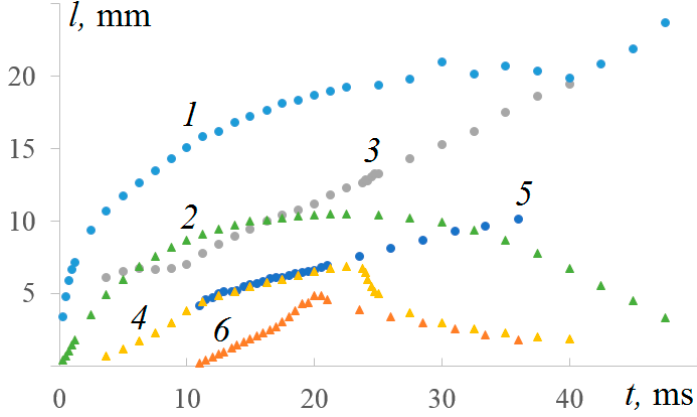
Figure 13. Evolution of cavern sizes at different droplet contact velocities: curves 1, 3, 5 are diameters; 2, 4, 6—cavern depths at U = 3.1, 1.0, 0.34 m/s; more detailed experimental data are given in the captions to Figures 3, 7 and 10.